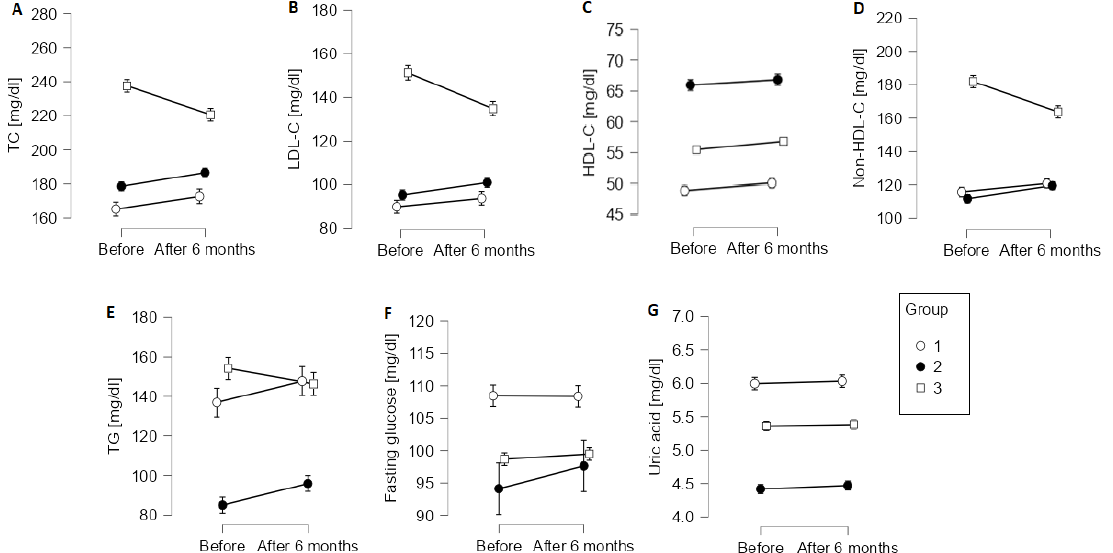
Figure 2. Change in laboratory variables from baseline to 6 months after completion of a course of cardiac rehabilitation in patient groups distinguished by cluster analysis. Error bars show 95% confidence intervals. TC, total cholesterol ( A ); LDL-C, low-density lipoprotein cholesterol ( B ); HDL-C, high-density lipoprotein cholesterol ( C ); Non-HDL-C, non high-density lipoprotein cholesterol ( D ); TG, triglycerides ( E ); Fasting glucose ( F ); Uric acid ( G